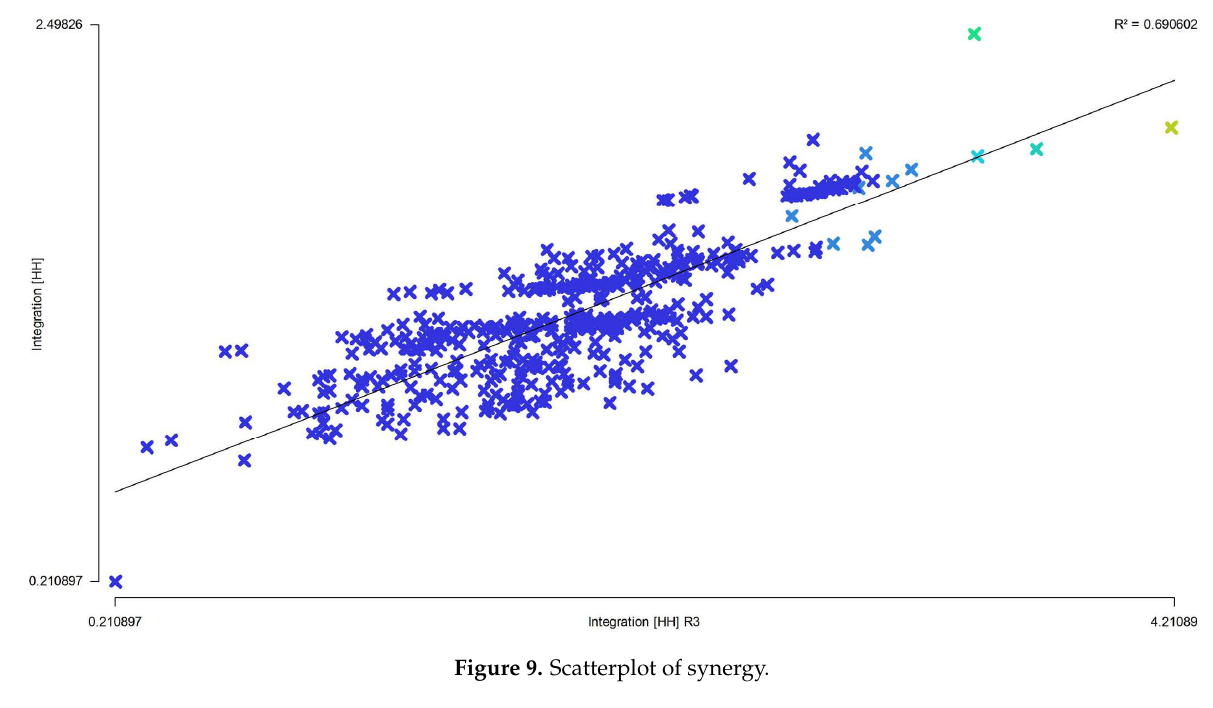
12 of 21 Table 1. Bir El Bey roads categories as a function of Integration Rn, Integration R3, and Choice values. Group Integration Rn Values